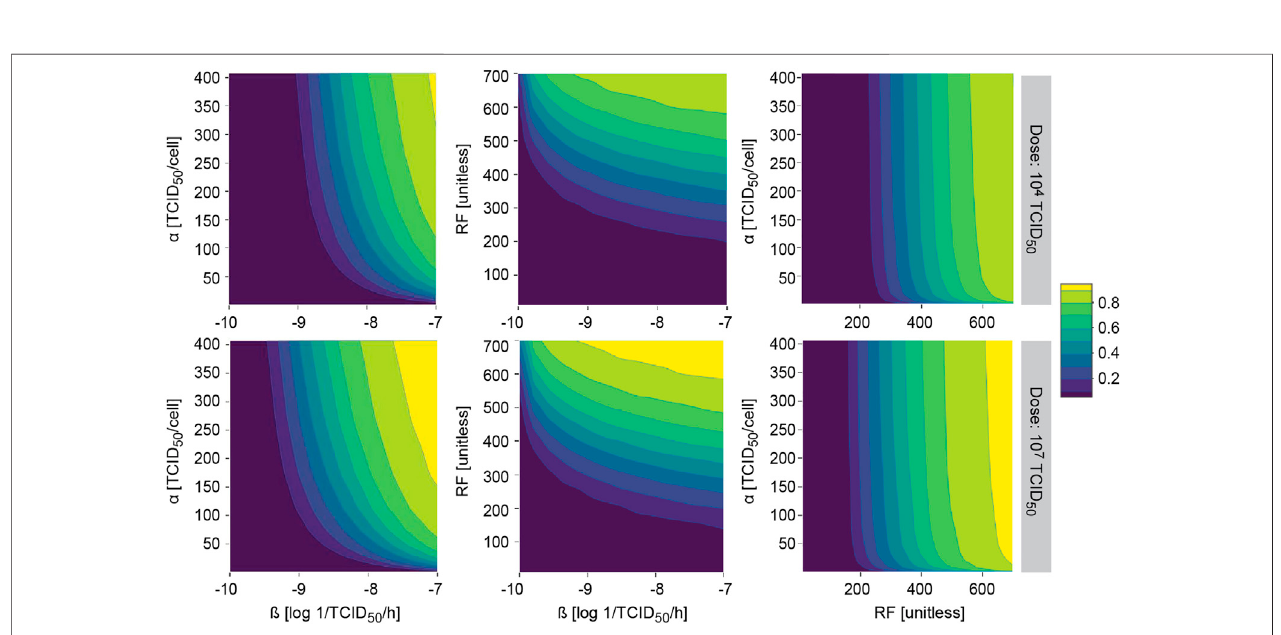
FIGURE 6 | Model applicability. Probability of observing at least 20% of tumor shrinkage at day 14 in a simulated virtual population at different two-by-two parameter combinations after single intratumoral dose. α , viral particles released per infected cell (viral production); β , viral infectivity; RF, retention factor.